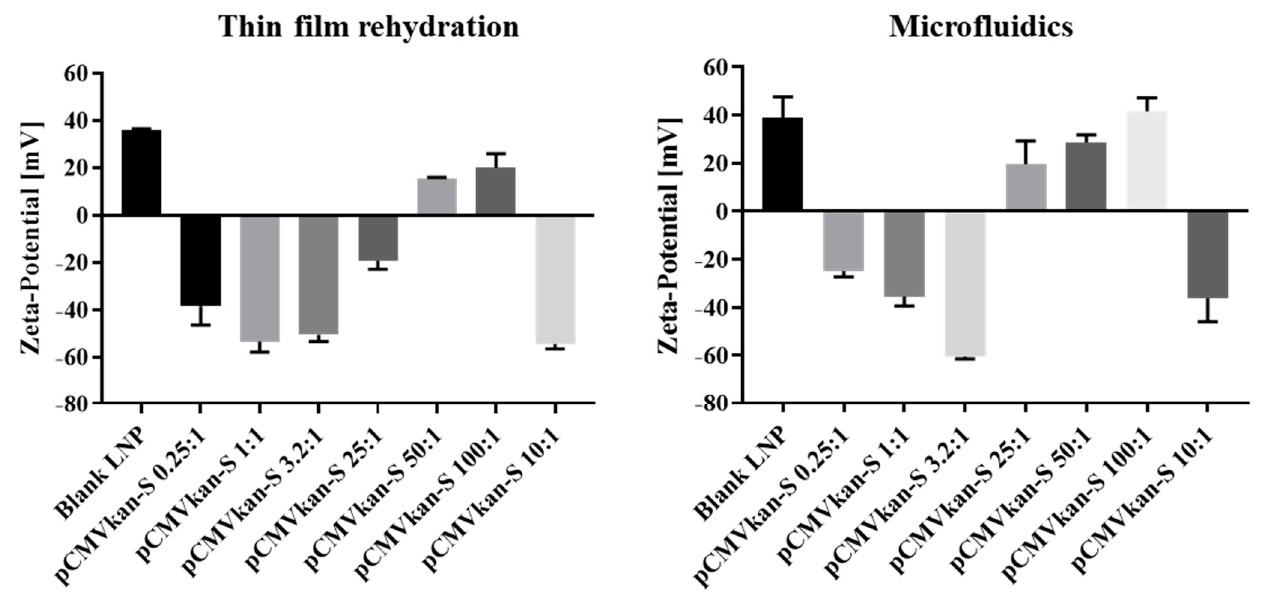
Figure 5. Zeta-potential results of DOTAP4/pCMVkan-S complexes at different N/P ratios. Graph on the left shows the results obtained with TF-manufactured liposomes. Graph on the right shows the results obtained with MF-manufactured liposomes. Data are represented as mean ± SD ( n = 3).